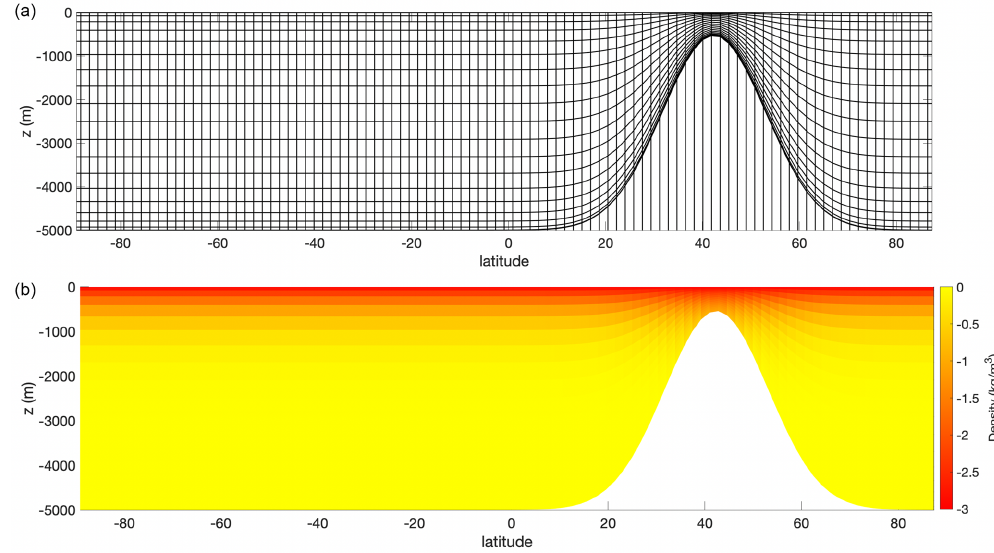
Figure 3. σ -Chebyshev grid (a) and initial stratification (b) for the seamount test case with δρ = − 3kgm − 3 .